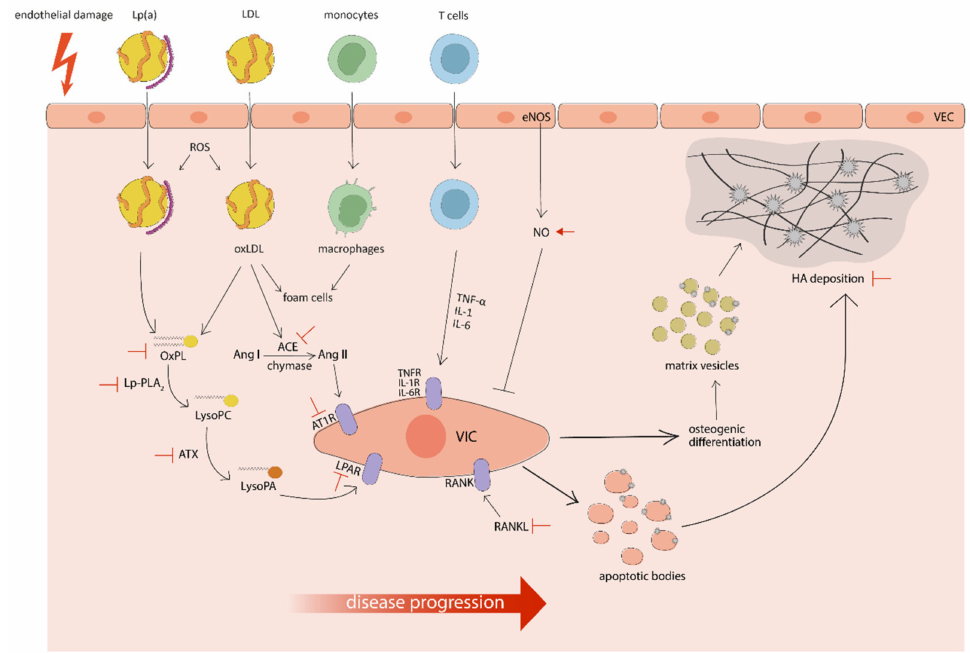
Figure 1. A simplified schematic representation of the pathophysiology of calcific aortic valve stenosis with targets under investigation for medical treatments and potential interventions (in red). The regular arrow means “activation”, the T-shaped arrow stands for